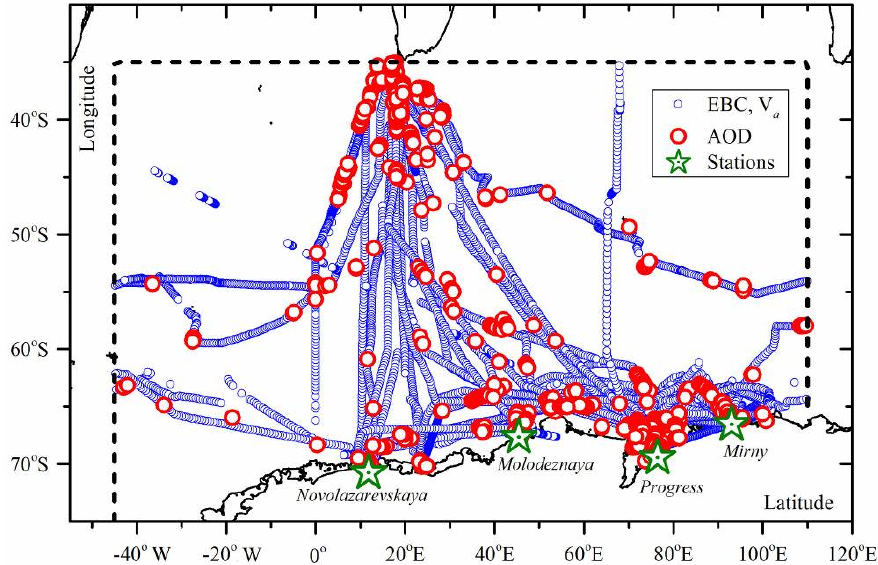
Figure 1. Locations/sites of the measurements of aerosol characteristics on the routes of the Antarctic expeditions in the Indo–Atlantic sector of the ocean (34–70° S; 45° W–110° E).